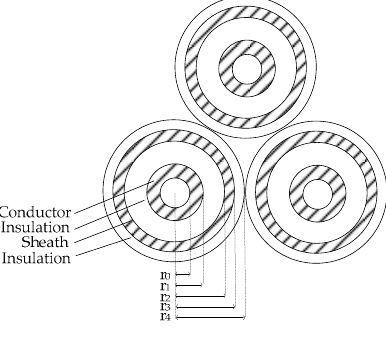
Figure 2. The cable arrangement. Table 1. The cable parameters and installation conditions.